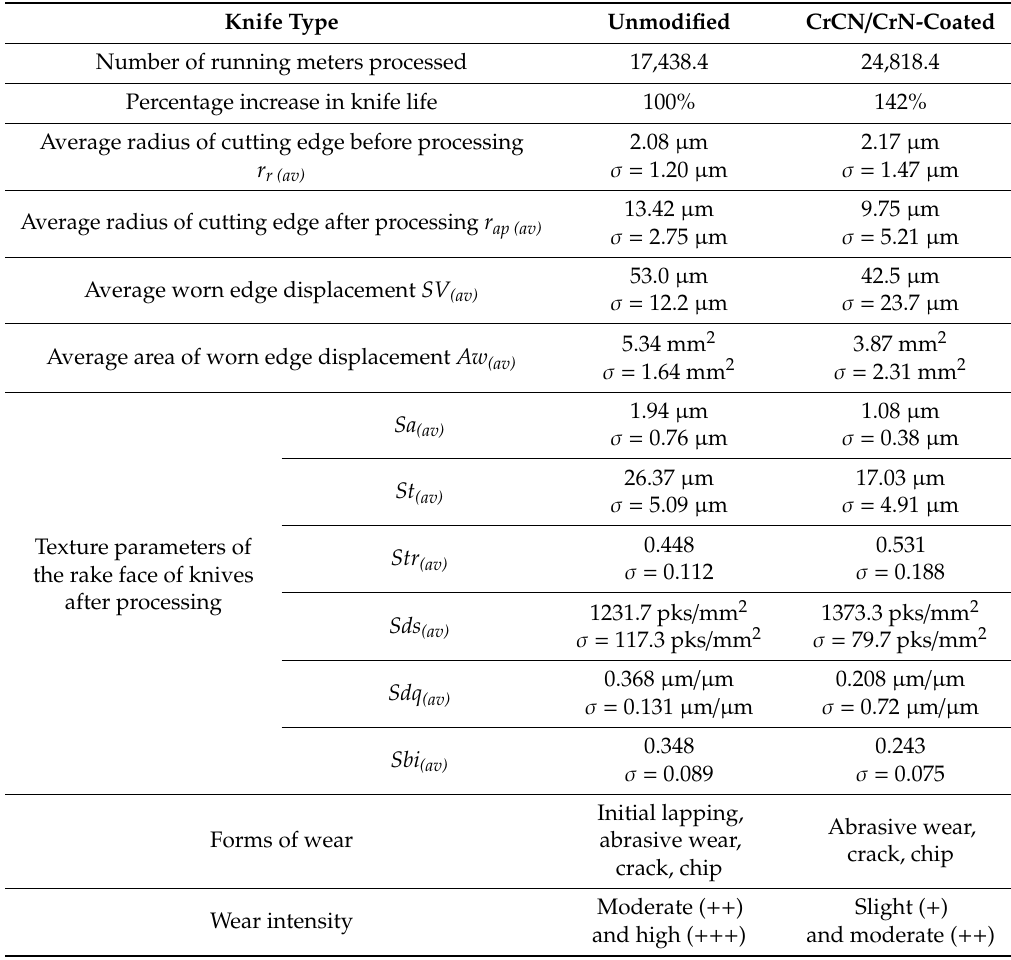
Table 5. Synthetic summary of the most important results of analyses conducted on the tested industrial planer